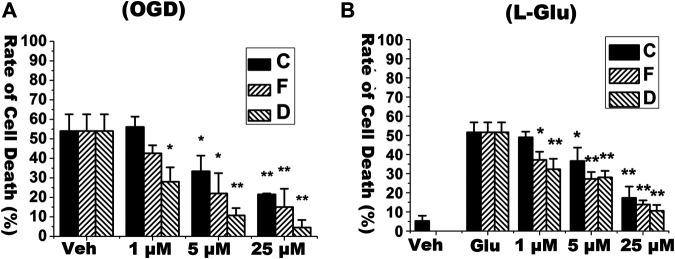
Isoflavones reduced the rate of cell death in primary cultured neurons under OGD/RO or l-glutamate-challenges. Rate of cell death was determined with LDH release assay. Isoflavones including calycosin (C), formononetin (F) and daidzein (D) were added into cultured media at the indicated concentrations prior to OGD/RO or l-glutamate (Glu) exposures. (A) Primary cultured mature neurons (DIV10) were exposed to 4 h OGD followed by 20 h RO. (B) Neurons were treated with 8 mM l-glutamate for 6 h. “Veh” means vehicle control that receives same volume of dissolvent. Data were represented as Mean ± SD, n = 4 (*p < 0.05, **
p < 0.01, compared to vehicle control).